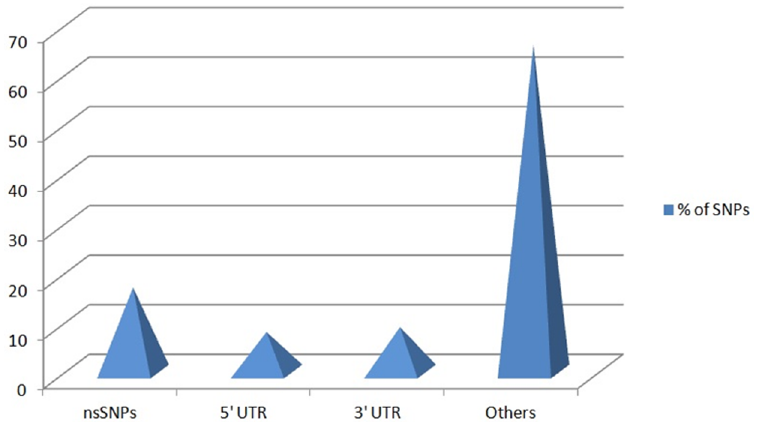
Fig 1. Clustered Pyramid showing the percentages of the SNPs in TAGAP gene. (nsSNPs: 17%; 5’UTR SNPs: 8%; 3’UTR SNPs: 9%; Other SNPs: 66%).